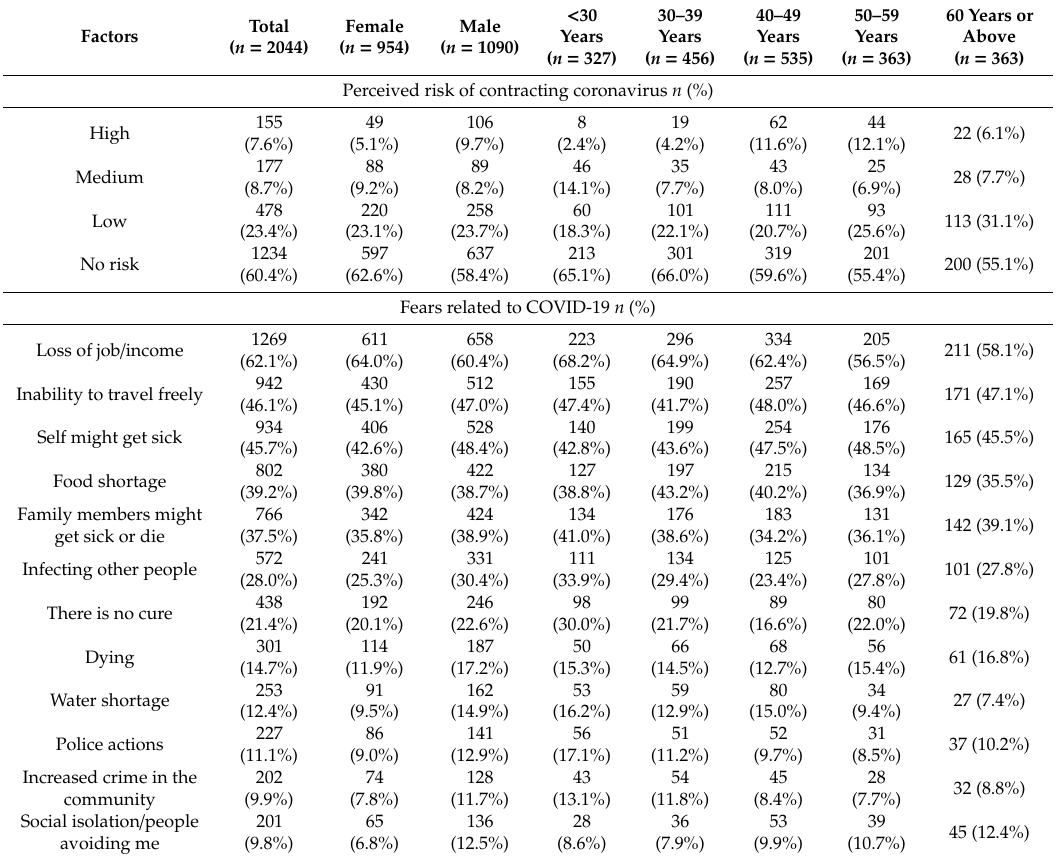
Table 2. Perceived risk of contracting coronavirus and fear of COVID-19 by gender and age group across study communities, Tamil Nadu, India, May